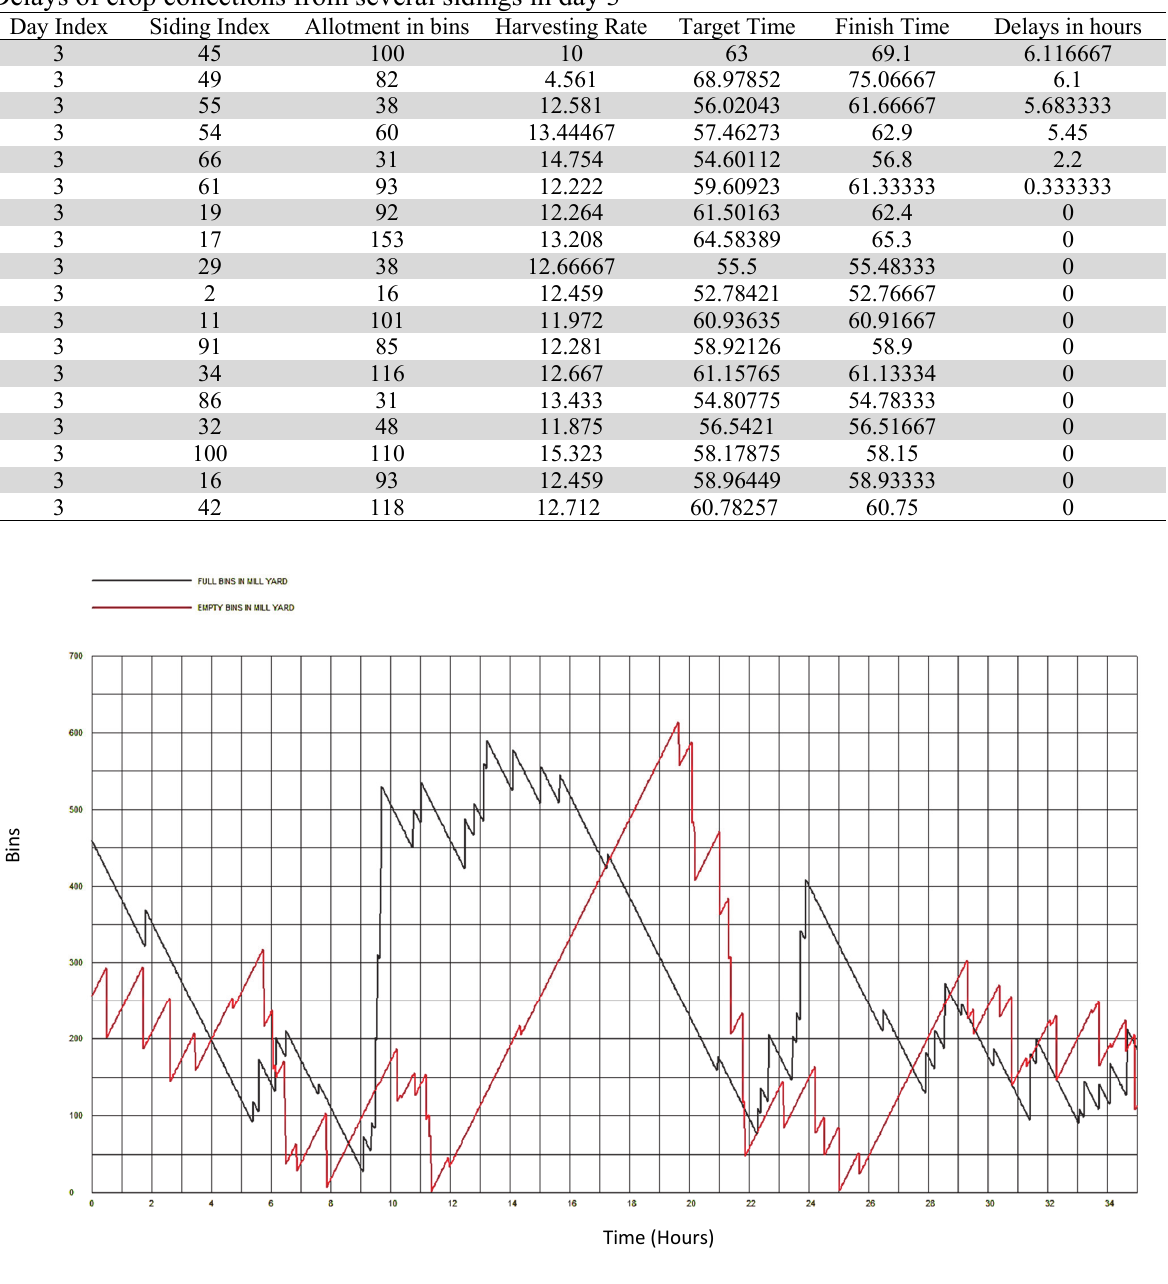
Fig. 10 . Empty and full bins at Mill in the Third